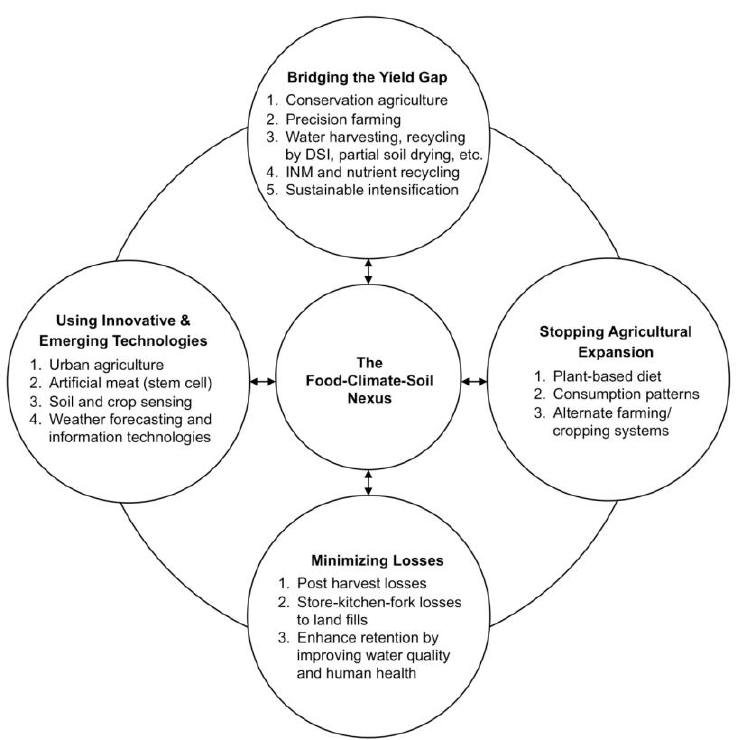
Figure 5. Halting agricultural expansion while achieving food security, mitigating climate change through soil and water management and altering consumption patterns and food